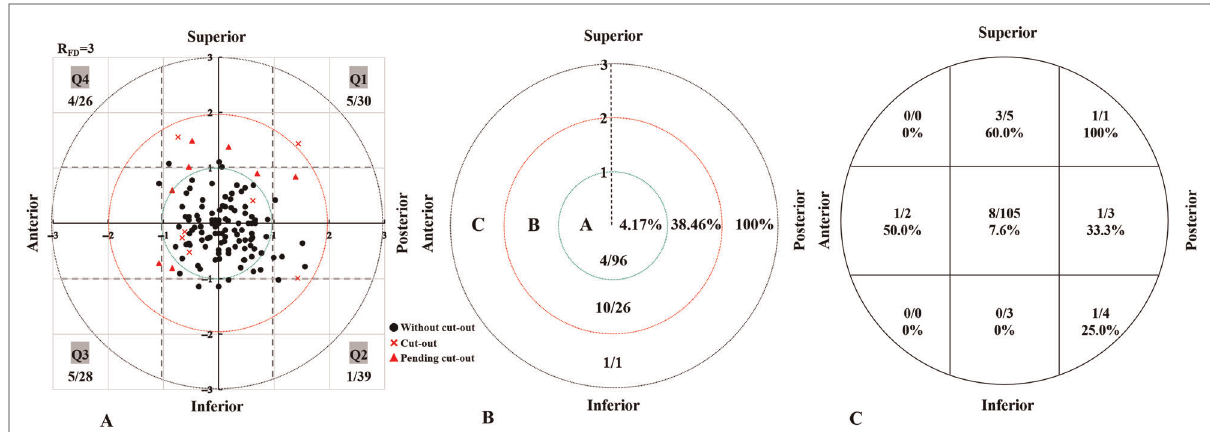
FIGURE 3 The distribution of cephalic fi xator tip placements according to the ED zone analysis system ( A ), the rate of cut-out in each zones based on ED zone analysis system ( B ), and the rate of cut-out in each zones based on Cleveland zone system ( C ). Cephalic fi xator position in ED Zone A has lower cut- out rate than that in the Cleveland Zone 5 (cut-out rate: R EDZoneC =4.17%, R ClevelandZone5 =7.62%). The cut-out rate in ED Zone A is signi fi cant lower than that in the region inside the Cleveland Zone 5 but outside the ED Zone A ( p =0.0016). ED, eccentric